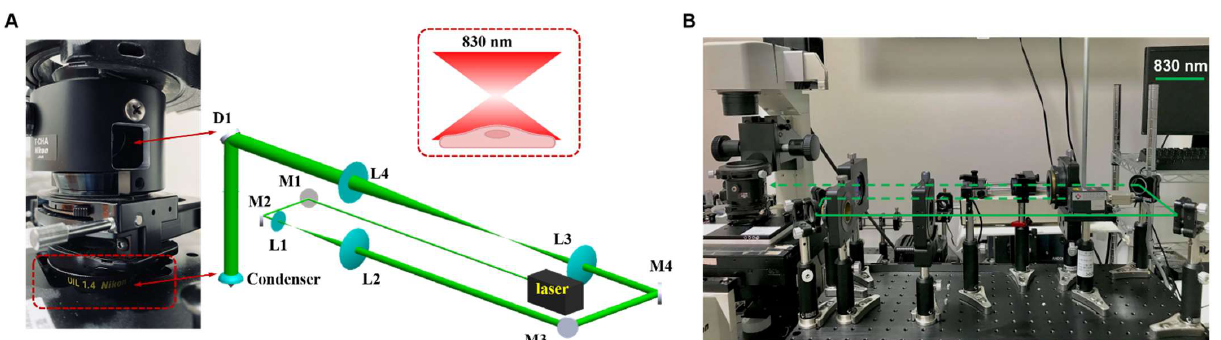
Figure 2. Experimental organization for the single-cell NIR laser irradiation system. ( A ) The proposed experimental setup consists of an 830 nm infrared diode laser, an electrical shutter, laser-focusing optics (condenser), and a specimen holder attaching to the XY-axis motorized stage. The lens pairs, which were used to expand the laser beam eightfold, were combined by two telescopes, including a 1:4 telescope (L1:L2) and 1:2 telescope (L3:L4) with the aim to fill the back aperture of the condenser. The dichroic mirror D1 is located between the visible light source and the condenser to reflect the laser beam into the condenser while allowing visible light to pass for bright field imaging. ( B ) The experimental setup for the proposed single-cell PBM irradiation system .